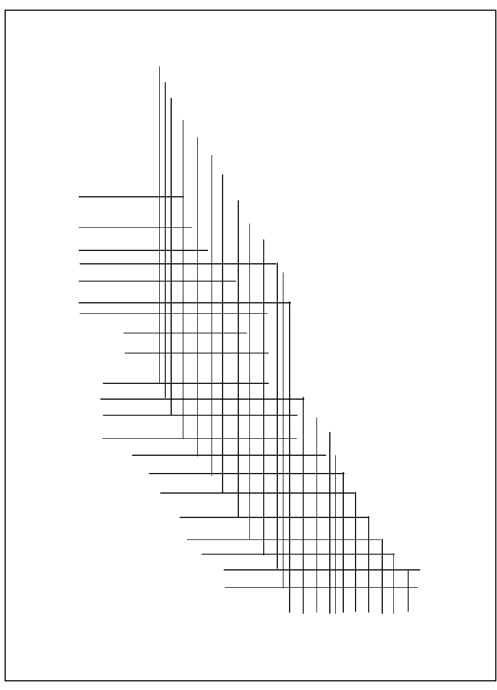
FIGURE 4. The tree of overtones in a simpler version. This figure illustrates a part of the pattern, as it would look on a millimeter paper.